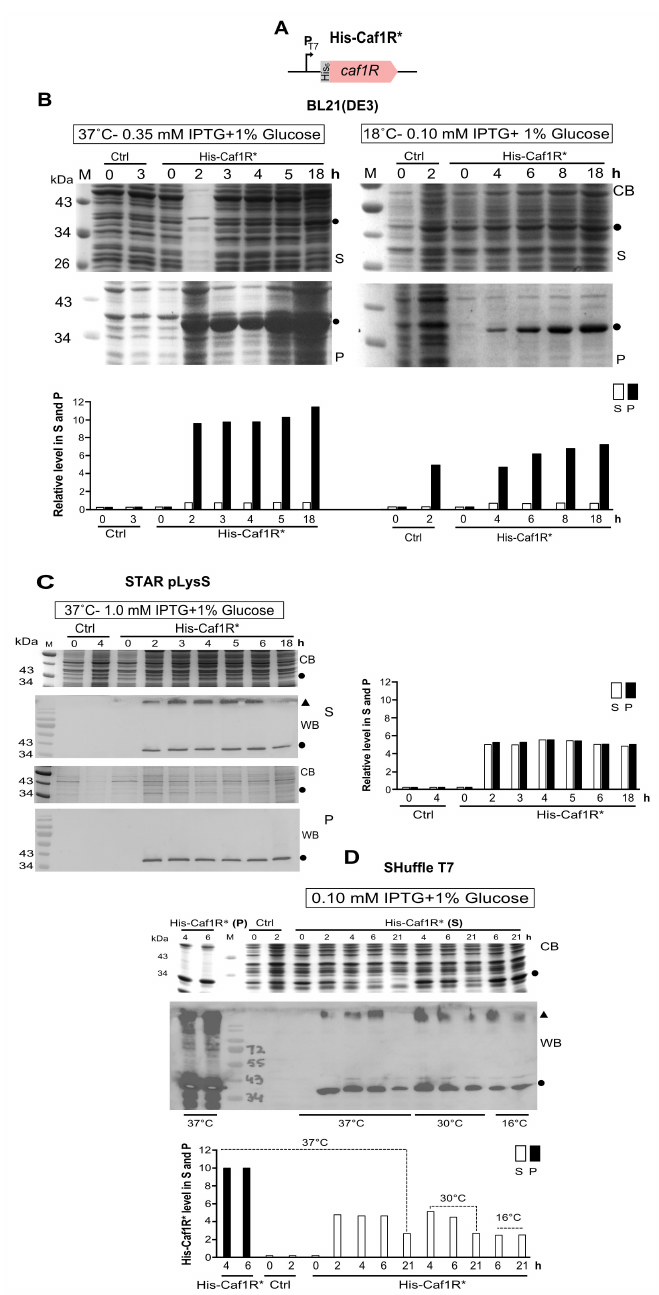
Figure 3. Expression of His-Caf1R* (codon-optimised caf1R ) from E. coli BL21(DE3) and its variants. ( A ) Schematic of His-Caf1R* from pEThCaf1R* plasmid. Soluble (S) and insoluble (P) fractions of His-Caf1R from E. coli BL21(DE3) ( B ) and its two variants, STAR pLysS ( C ) and SHuffle ( D ) were prepared after specified IPTG-induction at 37 ◦ C, 30 ◦ C, 18 ◦ C and 16 ◦ C. The S and P fractions were prepared by mixing an equal number of cells [1 OD unit] in 100 µ L of Bugbuster master mix followed by centrifugation [20,000 rpm–15 min/4 ◦ C]. Expected location of full-length His-Caf1R is indicated by a dot ( • ) and high-molecular weight insoluble aggregates is represented by a black triangle ( ∆ ). Expression of His-Caf1R* is validated by western immunoblotting with anti-His-HRP monoclonal antibody, and comparison with negative control, Ctrl (corresponding strain containing empty plasmid, pET28a + ). CB- Coomassie blue stained SDS-PAGE; non-induced samples [0 h] and M, protein size (kDa) marker. Relative level of total His-Caf1R in S and P fractions of respective strain was quantified, from CB-stained SDS-PAGE ( B ) and from western blot ( C , D